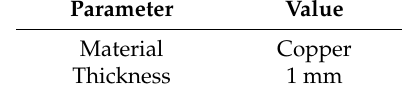
Table 3. Parameters of the copper plate. Table 4. Parameters of the magnet.